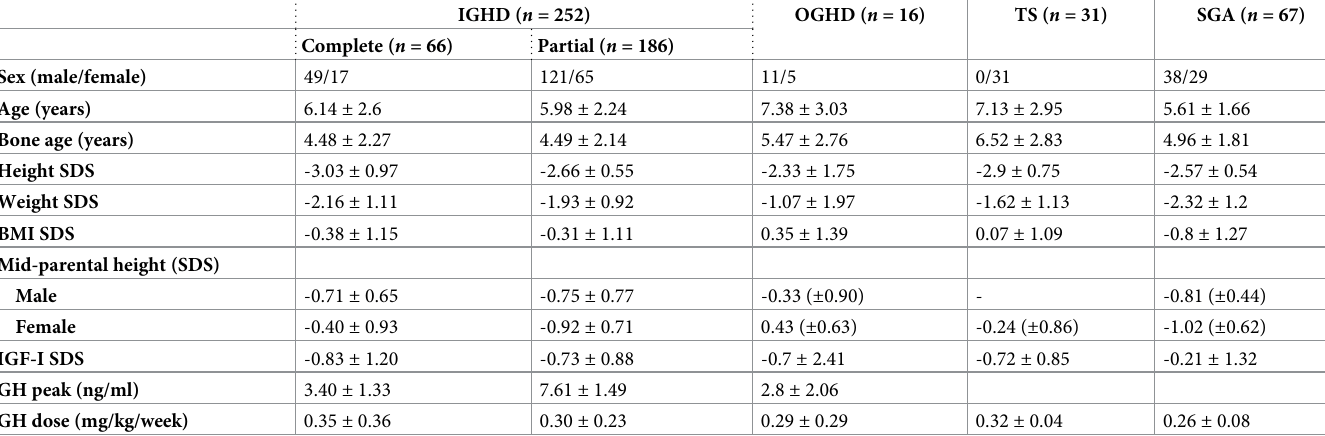
Table 1. Demography at screening.